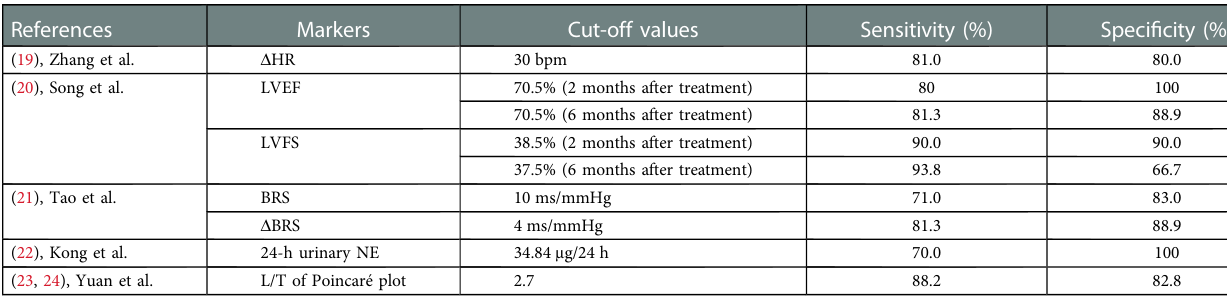
TABLE 1 Markers in predicting the therapeutic ef fi cacy of beta-blockers in children with